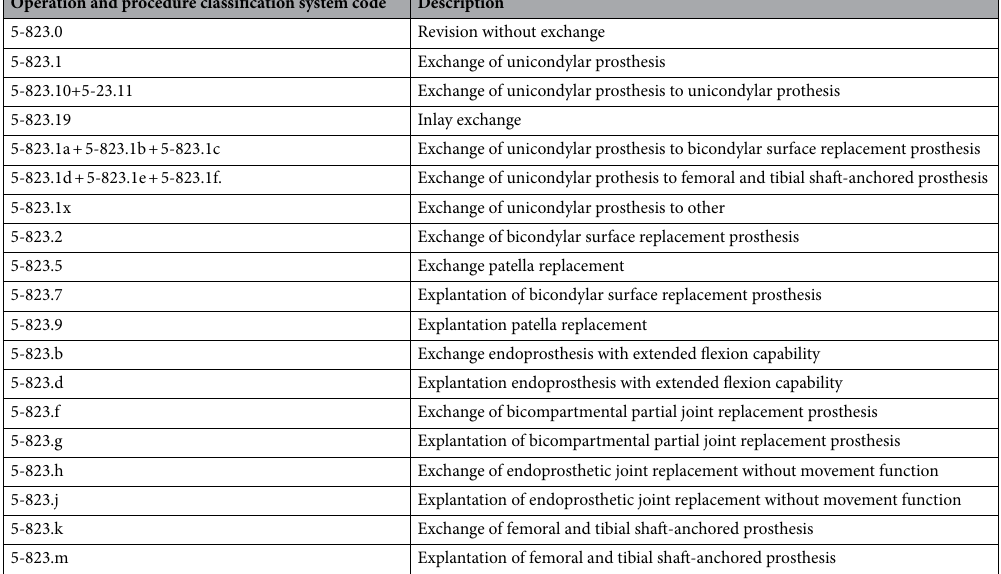
Table 1. Operation and procedure classification system code